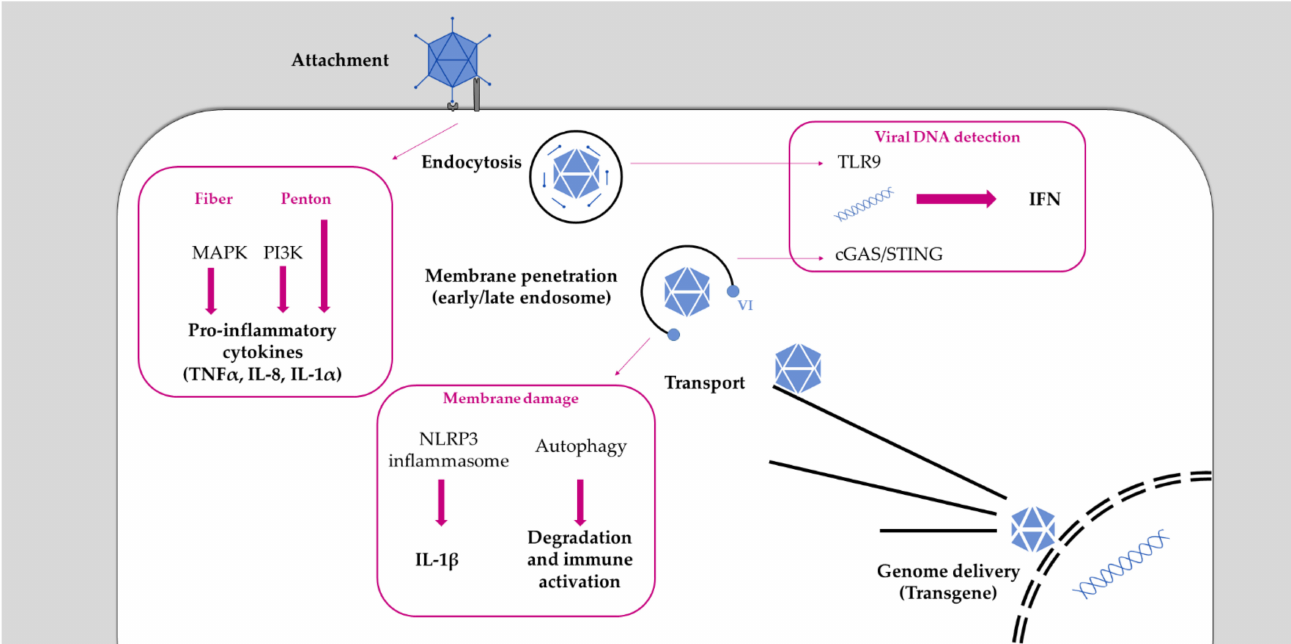
Figure 1. Adenovirus cycle and associated immune response. Along its journey to the nucleus, Ad faces several cellular immune restrictions. Interaction of fiber and penton are required for initial attachment of Ad to cellular receptors; this interaction also induces a signaling cascade leading to the production of pro-inflammatory cytokines. Following entry, Ad is trapped inside an endosome where viral genomes can be detected via TLR9. The membrane lytic function of the viral protein VI allows viral penetration of the endosomal membrane, permitting viral escape into the cytosol. Endosomal escape occurs from within early or late endosome, depending on the Ad species. Membrane penetration of the viral capsid allows exposure of viral DNA in the cytosol that can be sensed by cGAS/STING. Membrane damage is also detected as a danger signal and induces both inflammasome and autophagy